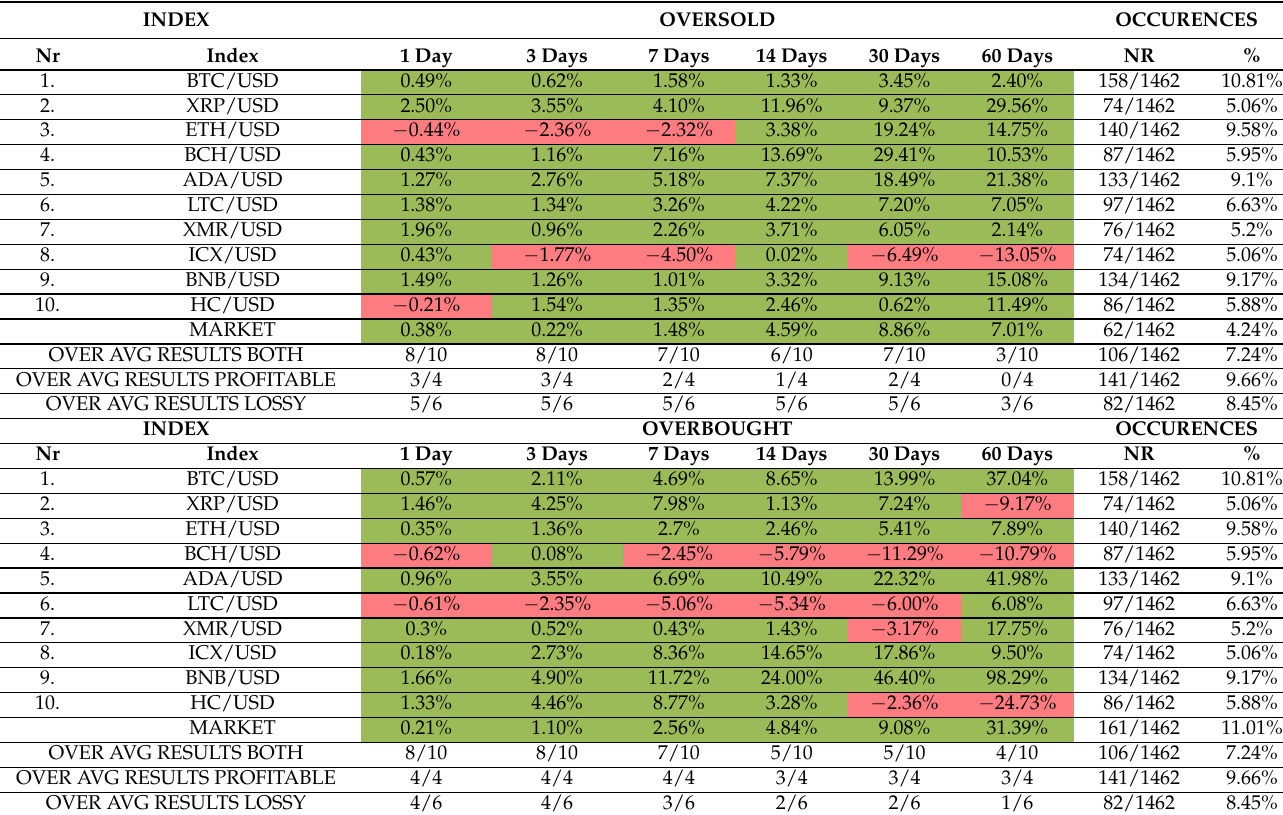
Table 2. Average returns of the examined cryptocurrencies after a selected number of days after the signal generated by the RSI application from the first experiment. In summary, the numbers indicate the number of indexes from a specific group that achieves above-average returns. Green indicates positive results, red indicates negative